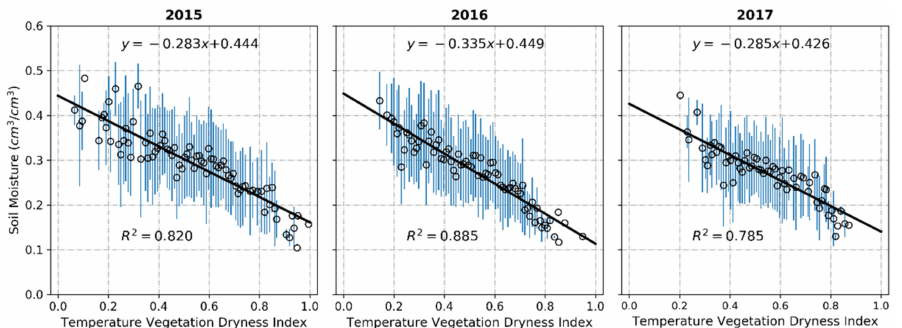
Figure 5. Relationship models between the TVDI and in situ SM. The blue lines represent the 95% confidence intervals of scatter points in the y-axis